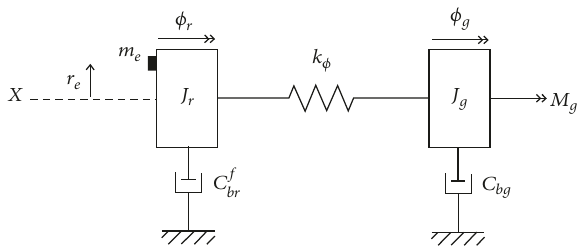
Figure 14: Engineering abstract of the test rig in torsional